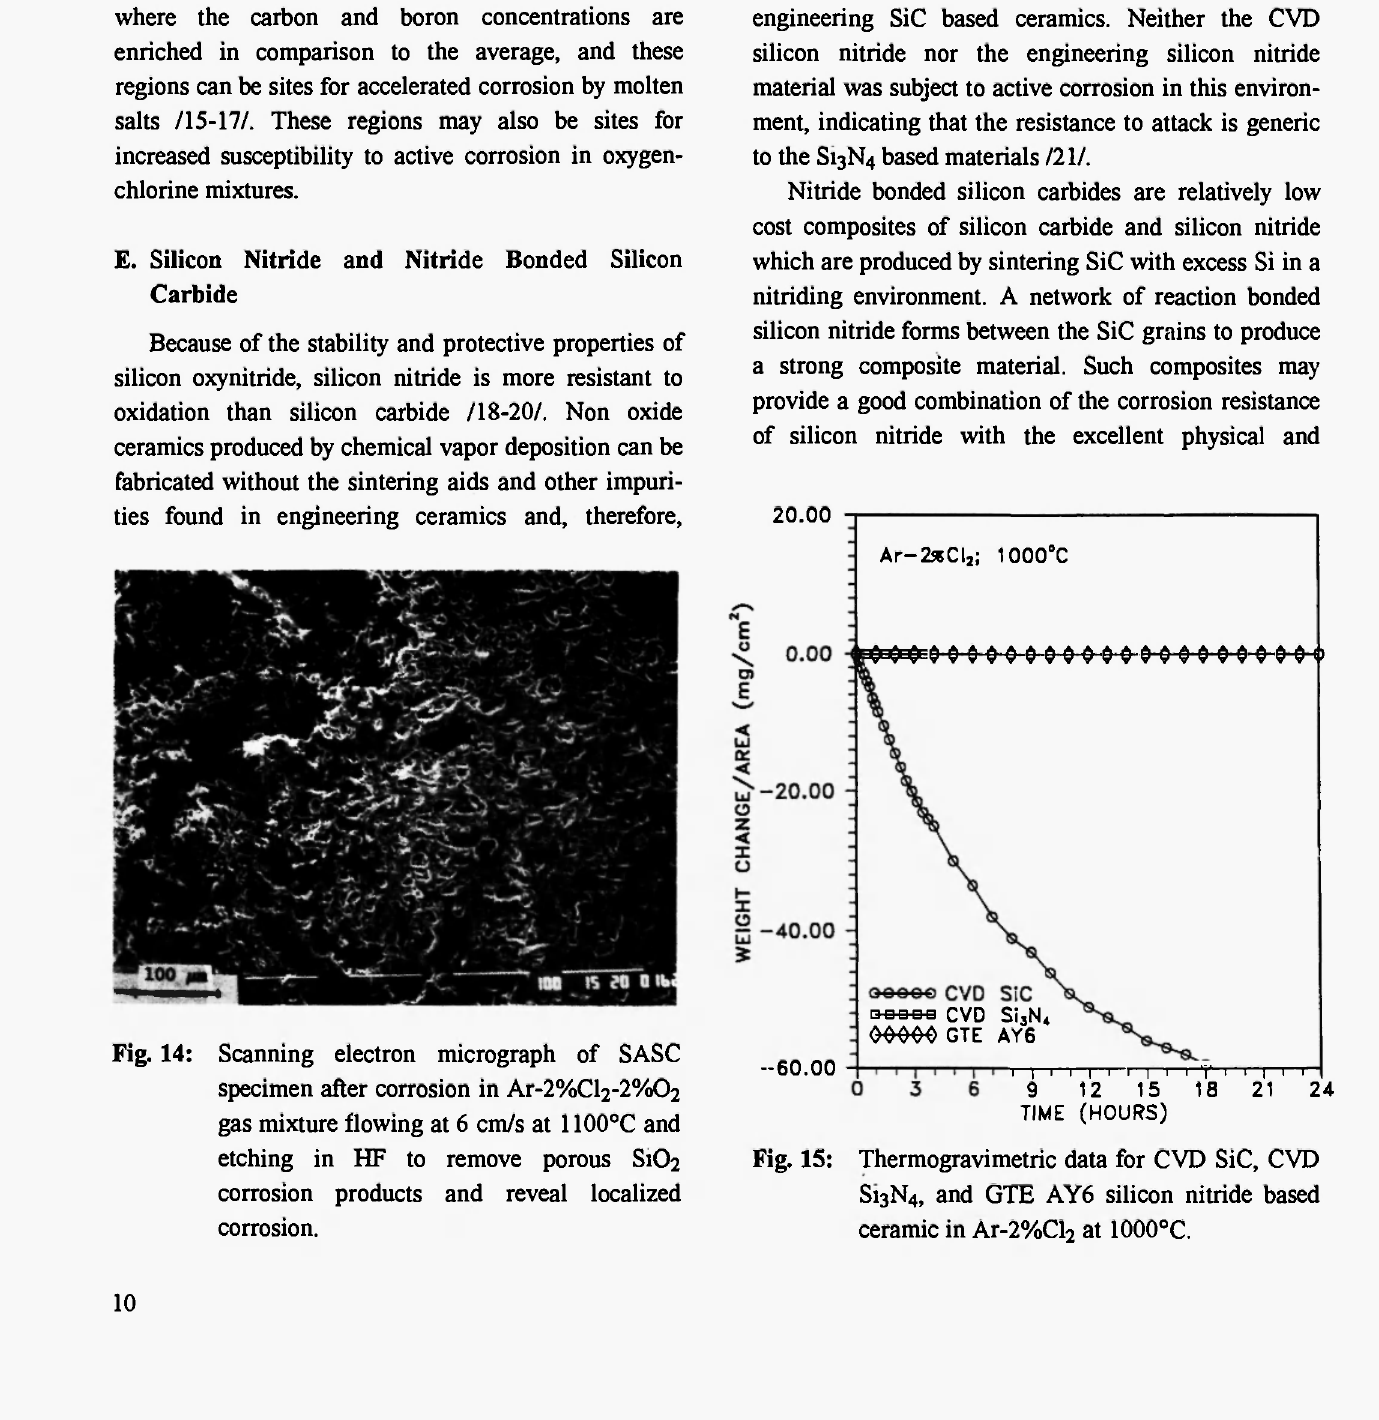
Fig. 14: Scanning electron micrograph of SASC specimen after corrosion in Ar-2%Cl2-2%C>2 gas mixture flowing at 6 cm/s at 1100°C and etching in HF to remove porous S1O2 corrosion products and reveal localized corrosion.